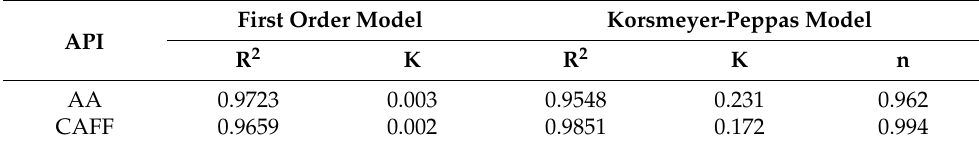
Table 10. Kinetics governing the release of AA and CAFF through M3.